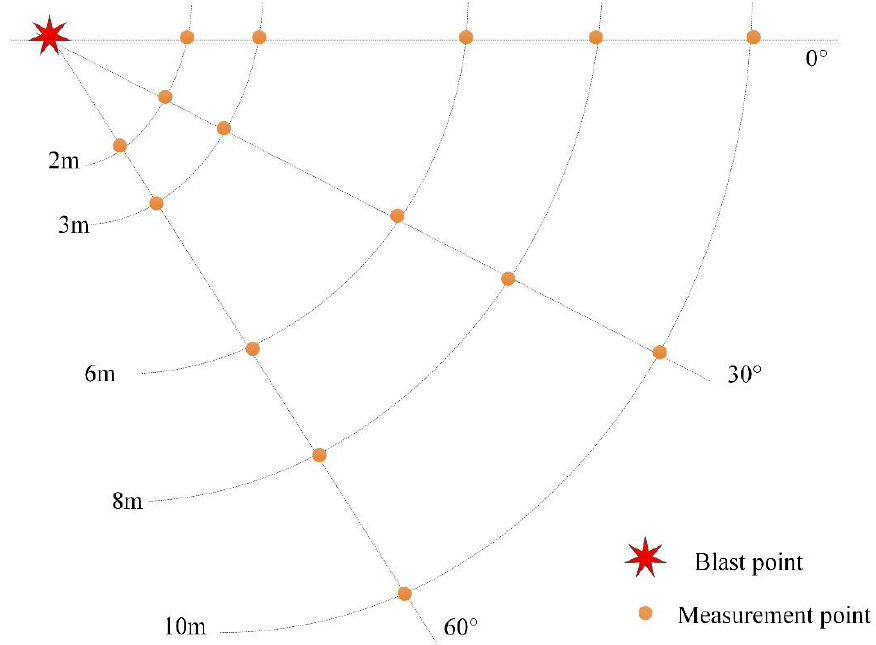
Figure 1. Schematic of the measurement points in the stationary charge explosion experiment.